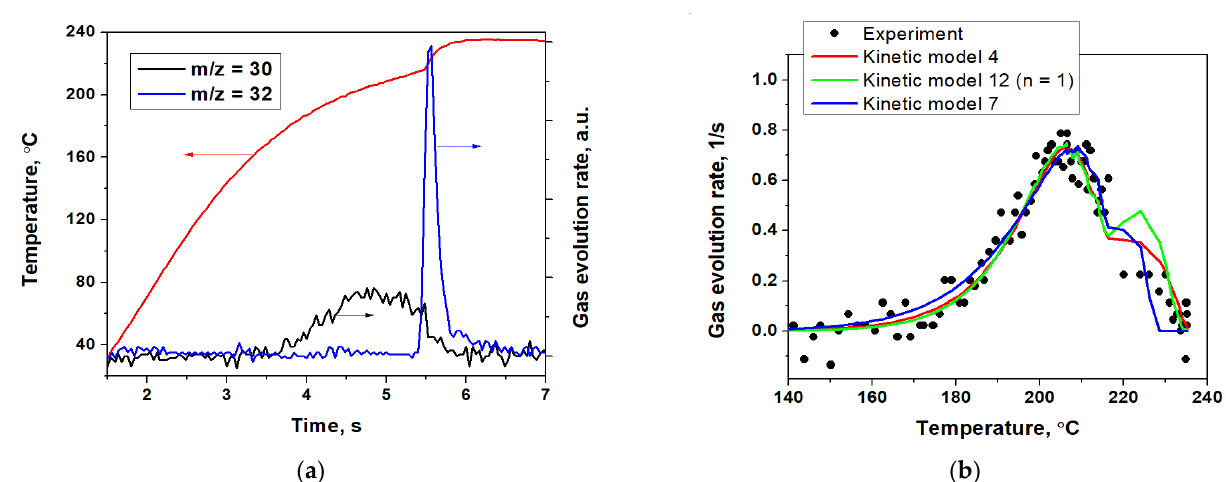
Figure 3. DMSTA results: ( a ) the evolution of gases with m / z = 30 and 32 and ( b ) the modeling of the evolution of the gas with m / z = 30 using the hybrid GA.